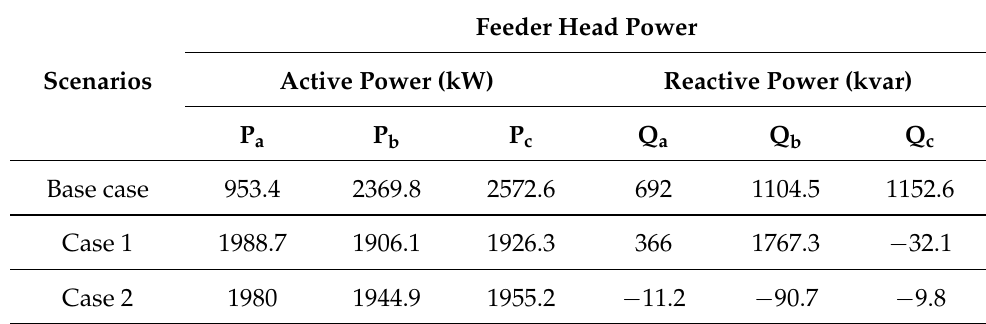
Table 1. Active and reactive power at the feeder head of base case, Case 1 and Case